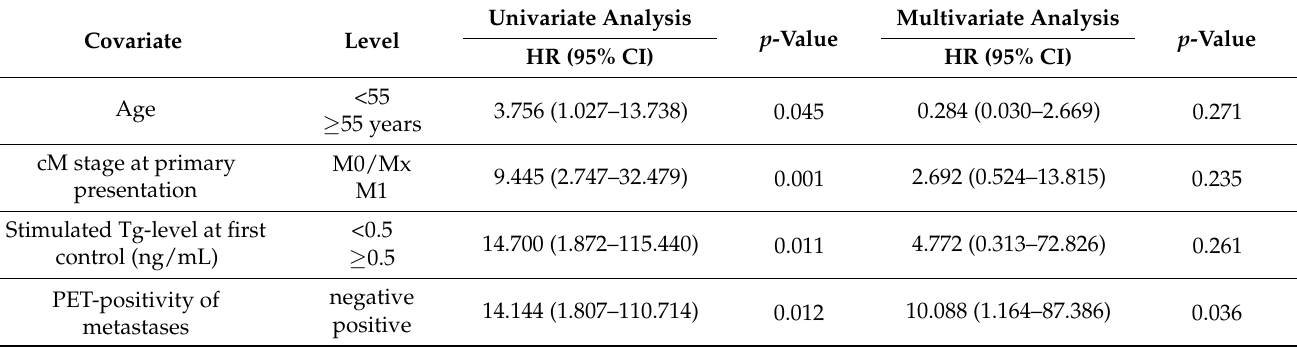
Table 3. Prognostic risk factors for poorer DSS in the uni- and multivariate analyses; DSS, disease-specific survival. Univariate Analysis p Covariate Level